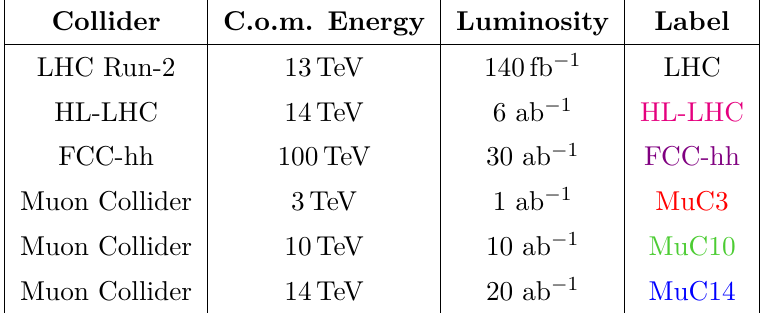
Table 1 . The energy and the luminosity of benchmark colliders. The detector specifications for FCC-hh and MuC are discussed in appendix D. The last column shows the short-hand label and color code for each collider, used for all the sensitivity plots in the